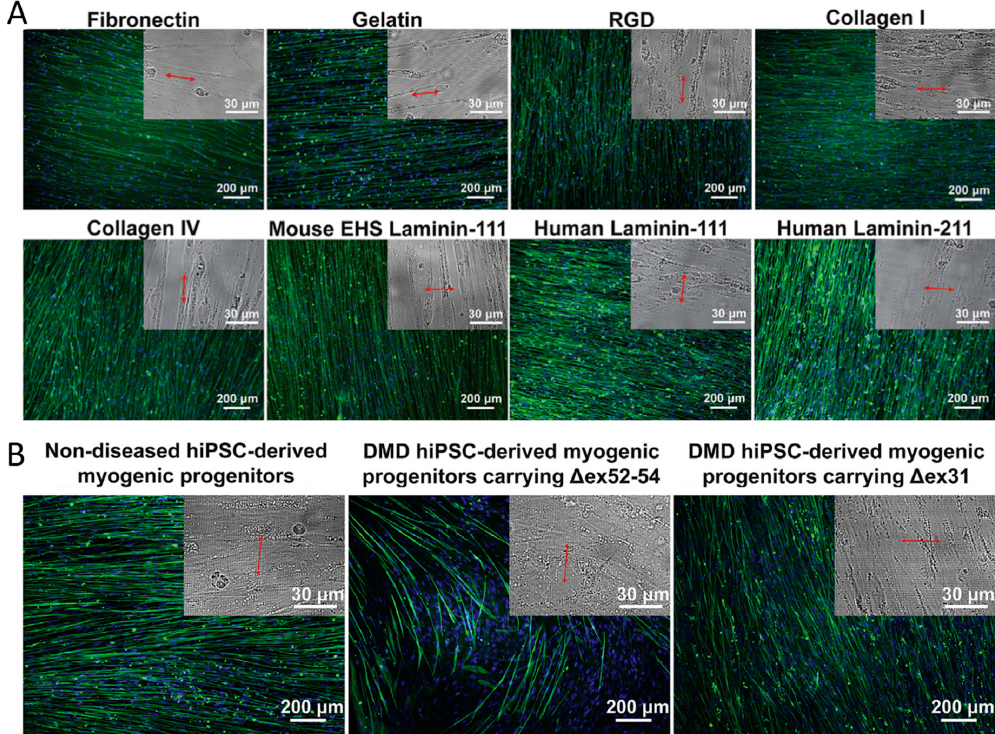
Figure 3. Myotube alignment and orientation on engineered substrates. ( A ) The effects of substrate-bound adhesion molecules on alignment and orientation of myotubes. Eight hundred nanometer grooved substrates were functionalized with different ECM components. ( B ) Myotube alignment and orientation on 800 nm grooved Matrigel-functionalized substrates to differentiate diseased and nondiseased cells (inset: bright-fie l d images show nanogroove directions (marked with red arrows)) [65] . “Reprinted from ref. [65] , Copyright 2018, with permission from Elsevier.”